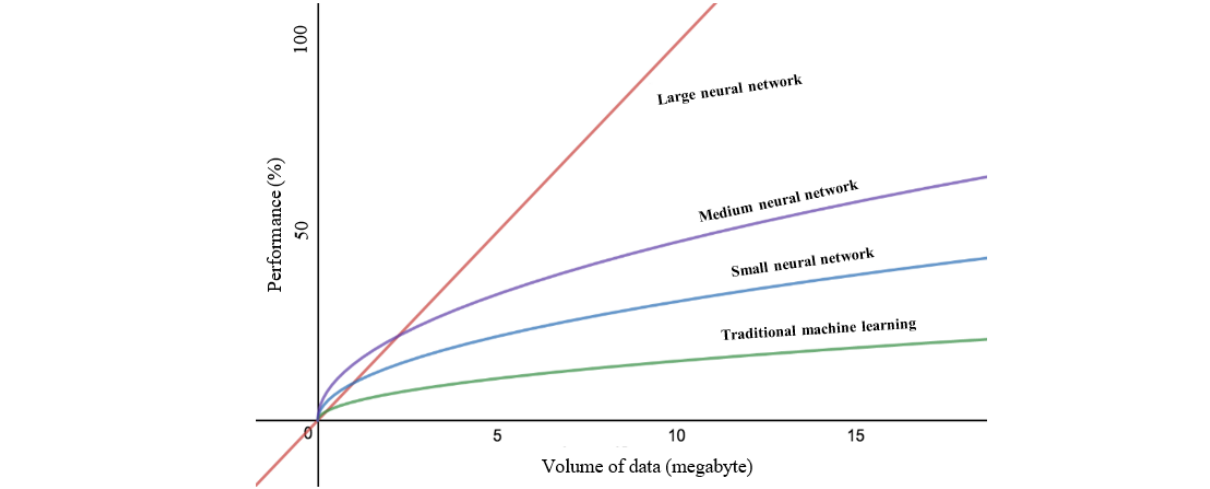
Figure 2. How machine learning techniques scale with amount of data.